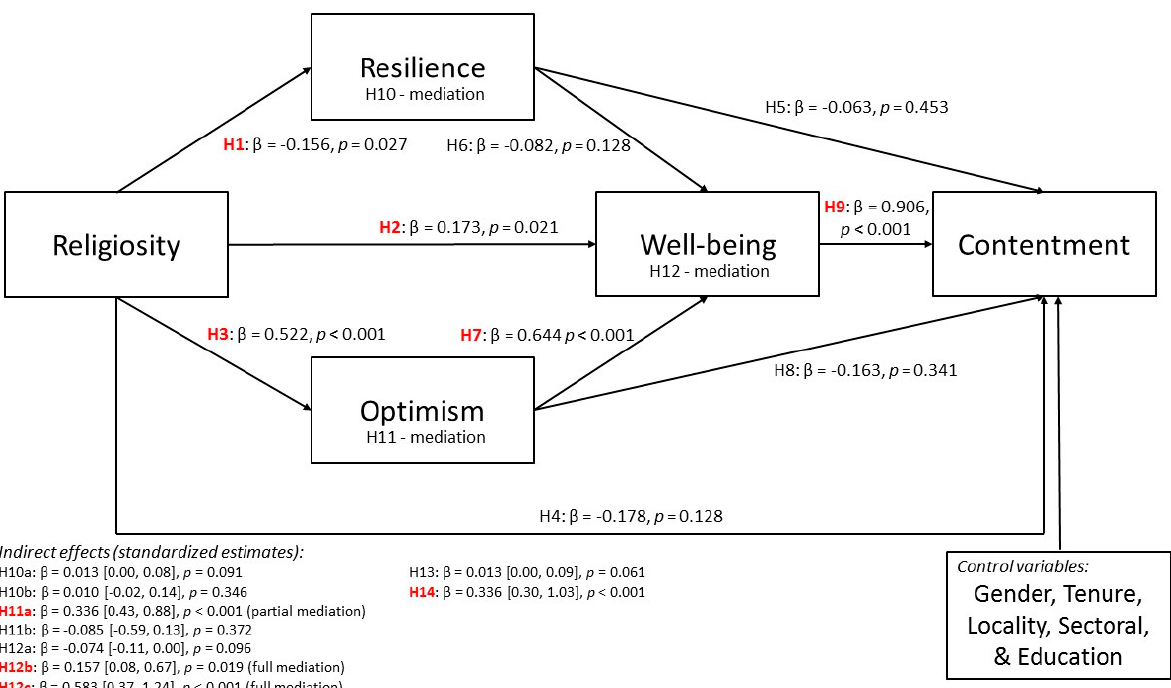
Figure 2. Mediating effects of resilience, optimism, and well-being between religiosity and contentment. Note: Notations is red denotes significant pathways.